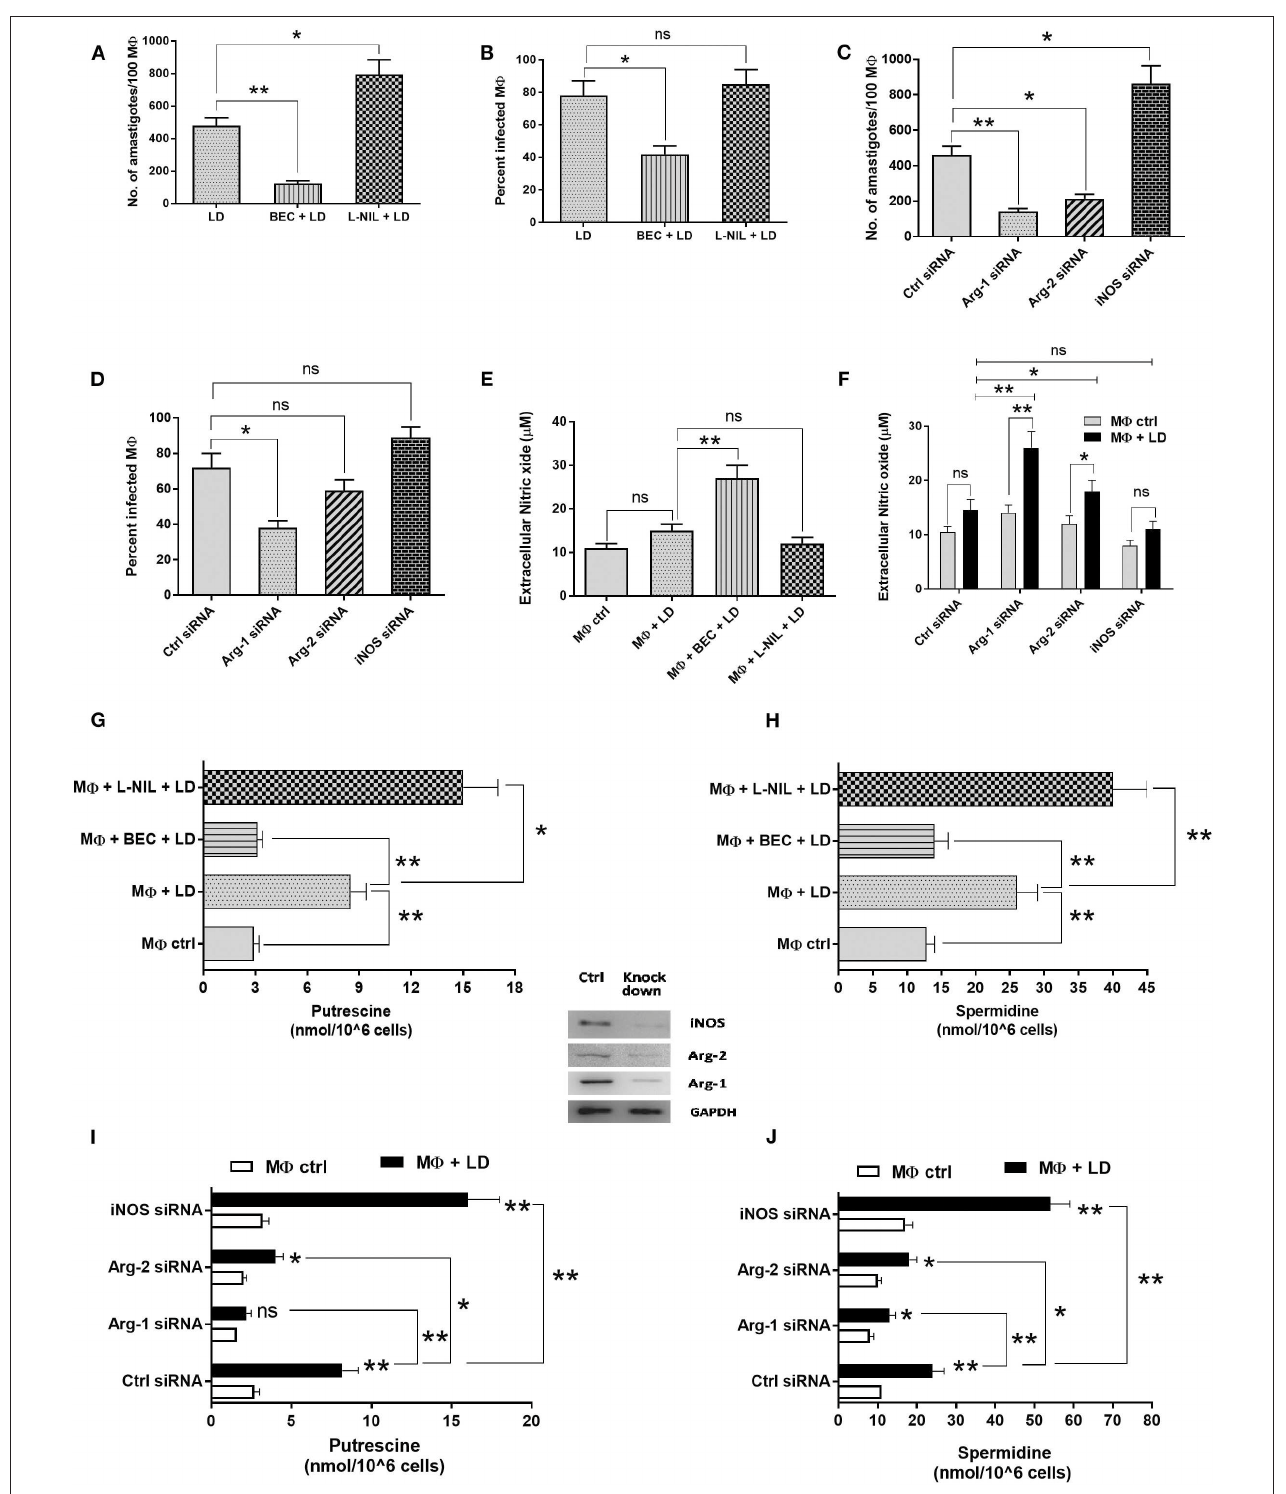
FIGURE 10 | Effect of regulation of arginase-inducible nitric oxide synthase (iNOS) balance in Leishmania donovani survival inside macrophages. THP-1 monocyte-derived M Φ s were either left untreated or preincubated with BEC (200 µ M) or L-NIL (100ng/ml) for 3h followed by infection with L. donovani for 48h (A,B,E,G,H) . In another experiment, THP-1 M Φ s were transfected with control siRNA, Arg-1, Arg-2, or iNOS siRNA followed by infection with L. donovani for 48h (C,D,F,I,J) . Intracellular parasites were visualized by staining the cells with Giemsa followed by optical microscopy at 100 × oil immersion. The parasite load